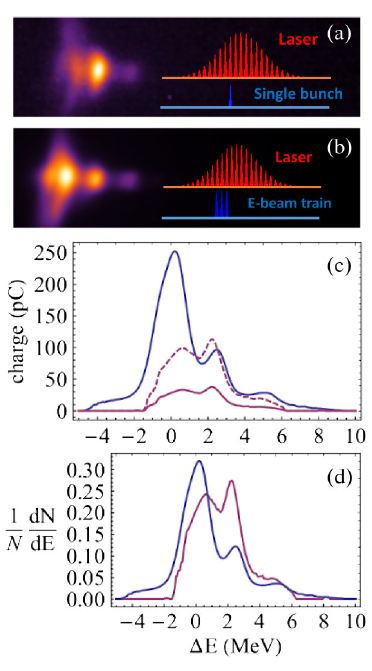
FIG. 6. Spectrometer images for single bunch (a) and three bunches (b) injected in the IFEL. Note that the gain is adjusted to maximize the dynamic range and avoid saturation of the images. (c) Charge normalized energy histograms for single bunch (red) and three bunch (blue). We also show for comparison the single bunch spectra scaled by a factor of three (red dashed) (d) Spectra corresponding to (a) and (b) are also shown normalized to unity for